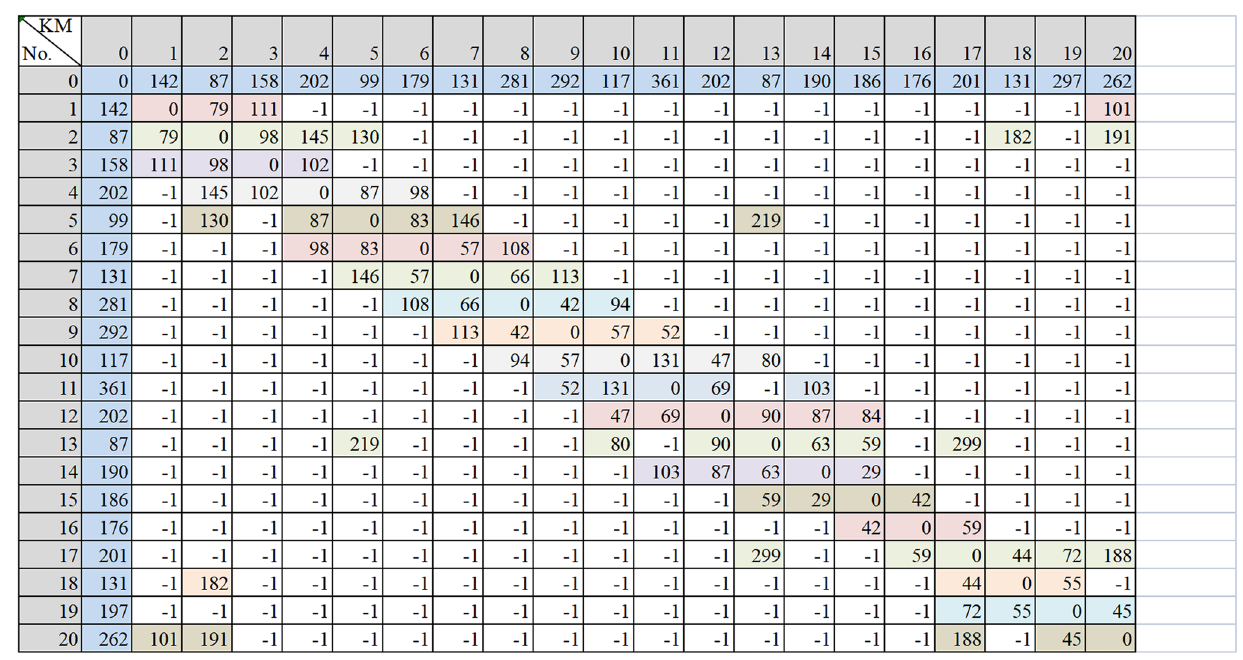
Figure 1. Transportation distance information from chemical logistics company to customer nodes. If the distance between customers is displayed as − 1, the road is disconnected. If the numbers are displayed, it represents the transportation